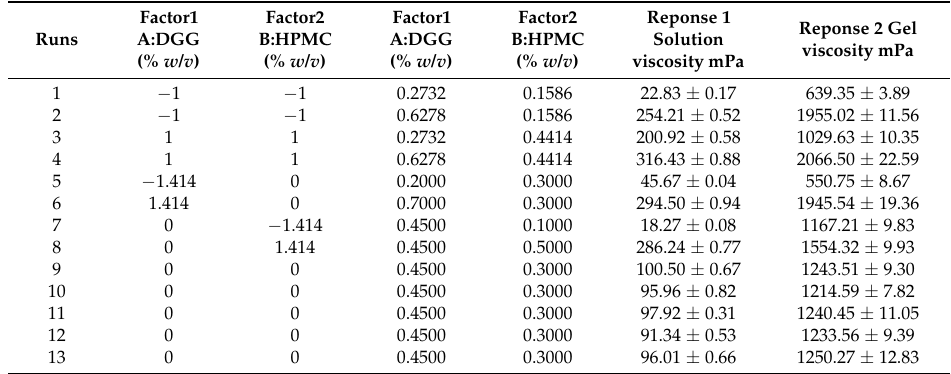
Table 3. Central composite design experiments and experimental results.